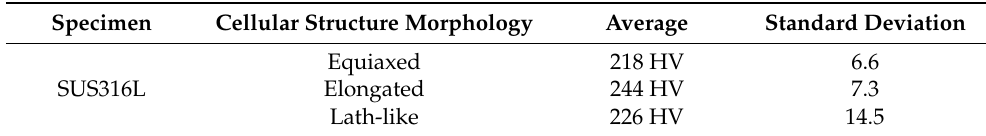
Table 3. Vickers hardness according to cellular structure